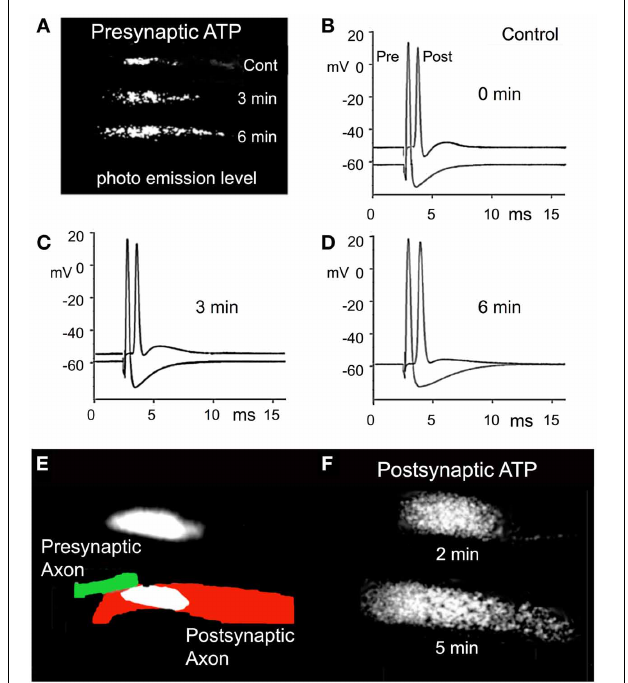
FIGURE 5 | Effect of RNS60 on ATP synthesis. (A) The levels of luciferin/luciferase light emission in control ASW (Cont) and 3 and 6min following RNS60 superfusion. (B) Presynaptic and postsynaptic action potentials in control ASW. (C) Action potentials recorded 3min after superfusion with RNS60. (D) Action potentials recorded 6min after superfusion with RNS60. (E) Drawing of presynaptic (green) and postsynaptic (red) element is superimposed on photograph of postsynaptic light emission. Presynaptic light emission is shown above the drawing. (F) Postsynaptic light emission 2 and 5min after superfusion with RNS60. Note increase in postsynaptic resting potential in (C,D) , indicating an improvement of postsynaptic axon viability that is consistent with the increased level of ATP measured at the postsynaptic terminal following RNS60 ASW